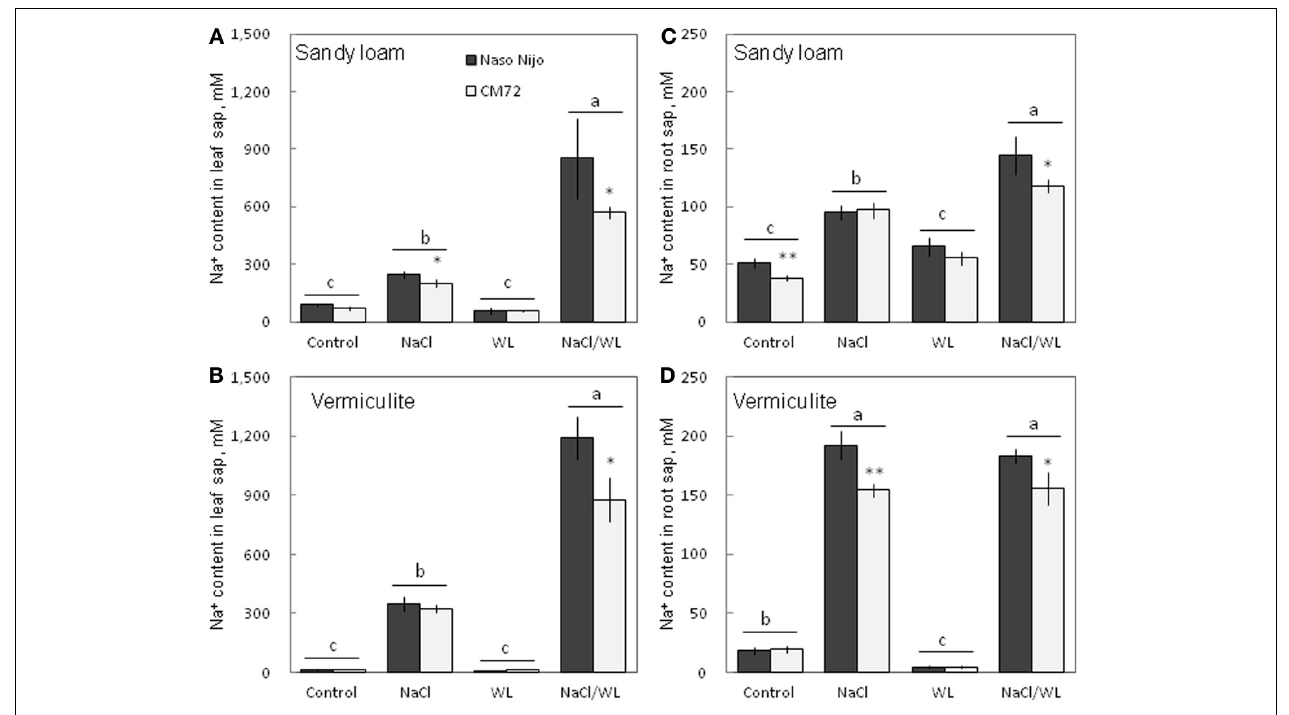
composition, refer to the Materials and Methods section. Mean ± SD ( n = 5). Different lower case letters indicate the significant difference between treatments (averaged for both genotypes) at P < 0 . 01. Asterisks indicate the significant difference between cultivars within treatment at ∗ P < 0 . 01, ∗∗ P < 0 .